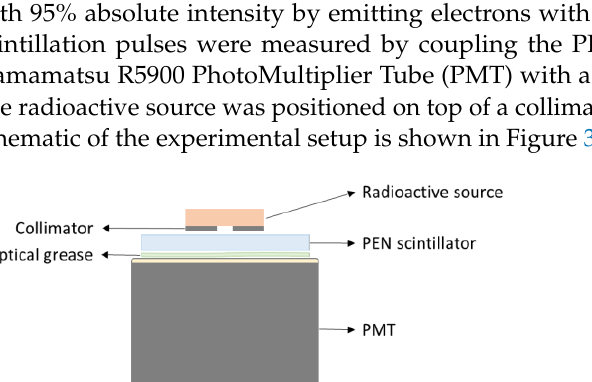
Figure 2. A 30 × 40 × 0.1 mm 3 thin-film flexible PEN scintillator illuminated with UV light.